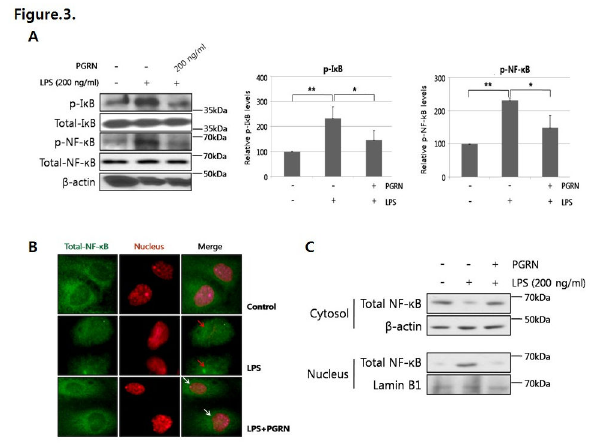
Figure 3. Progranulin(PGRN) inhibited LPS-mediated IκB and NF-κB activation. (A) Cells were incubated with LPS (200 ng/mL) or LPS and PGRN (200 ng/mL) for 15 min and analyzed by Western blotting for phosphorylated-IκB (p-IκB) and -NF-κB (p-NF-κB) levels. Data were obtained from three separate experiments. Error bars represent mean ±SD (*, P < 0.05, **, P < 0.005, t -test). (B) Immunofluorescence microscopy analysis was performed for identification of NF-κB location after 15 min of LPS or LPS and progranulin treatment. NF-κB was labeled by green fluorescence (FITC), and nucleus was stained by red fluorescence (propidium iodide). The red arrows indicate that NF-κB was translocated from the cytosol to the nucleus by LPS, and the white arrows mean that progranulin inhibited NF- κB translocation from the cytosol to the nucleus. (C) Cytosol and nuclear protein of LPS or LPS and PGRN-treated HUVEC were separated, and analyzed by western blotting for NF-κB